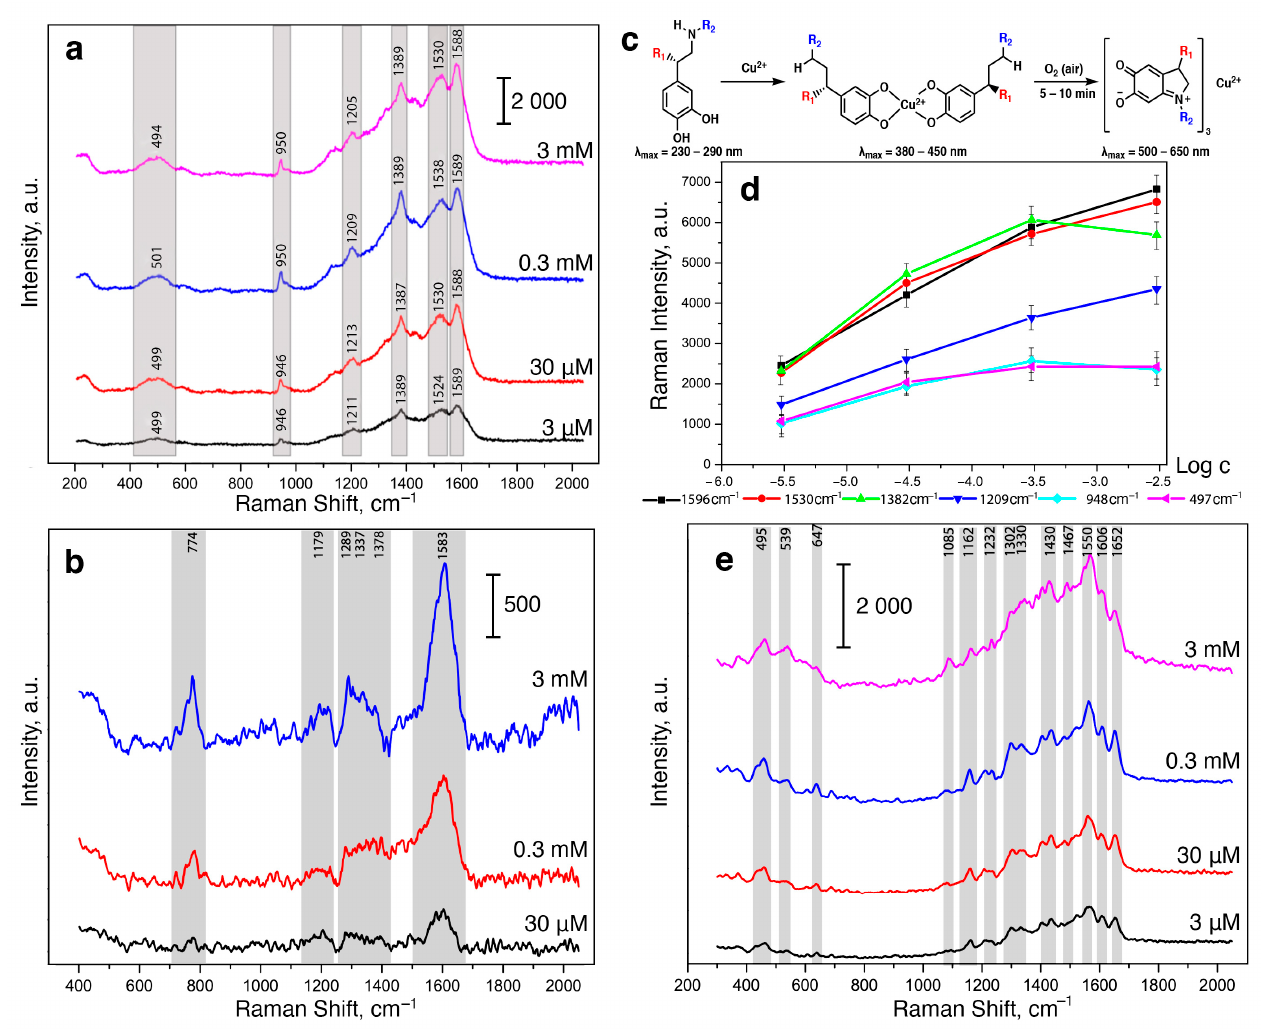
Figure 1. ( a ) SERS spectra of DA at 3 mM, 0.3 mM, 30 μ M, and 3 μ M concentrations with 3 mM Cu(II). ( b ) SERS spectra of NA at 3 mM, 0.3 mM, and 30 μ M concentrations with 3 mM Cu(II). ( c ) Scheme of (Cu(semiquinone) 3 ) − formation [45] . ( d ) Dependence of the intensity of SERS signals (at 1596, 1530, 1382, 1209, 948 and 497 cm − 1 ) on the logarithm of the DA concentration (M) in the presence of Cu 2+ (3 mM). Error bars are shown for n = 20, p = 0.95. ( e ) SERS spectra of AD at 3 mM, 0.3 mM, 30 μ M, and 3 μ M concentrations with 3 mM Cu(II). Spectra were measured on the silver nanostructured surface coated with the chitosan layer at 633 nm laser wavelength.